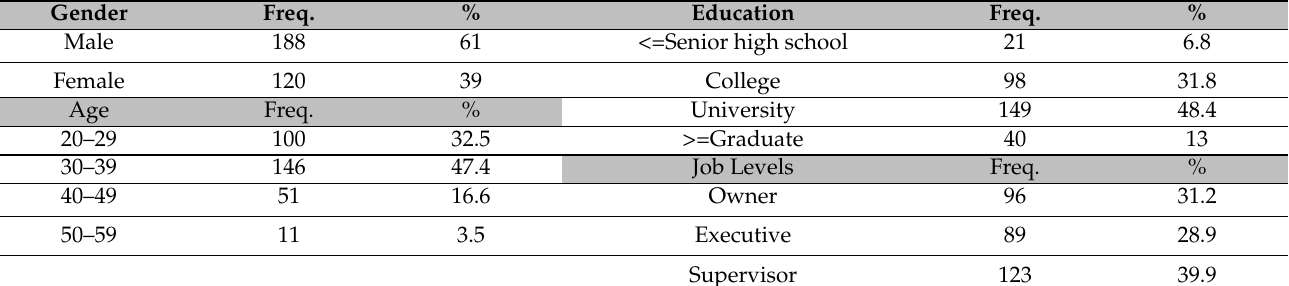
Table 2. Descriptive statistics of the respondents’ profiles.